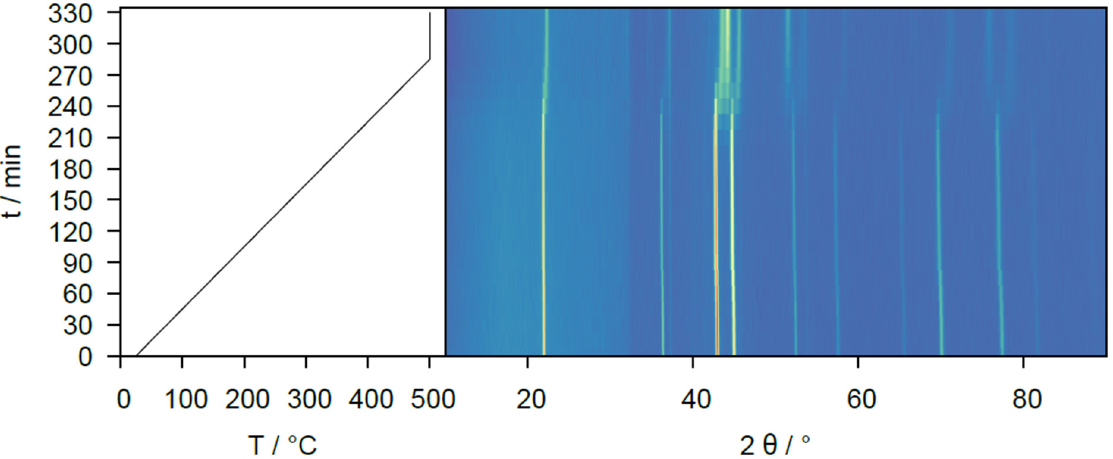
Figure 5. In situ X-ray powder diffraction of Ca x Mg 1 − x Ni 2 ( x = 0.5).